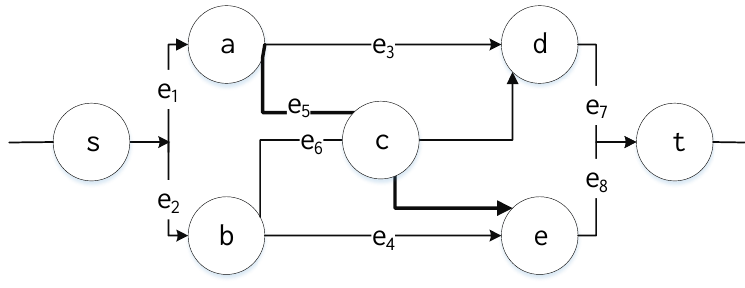
Figure 6. Edge marked in the network.